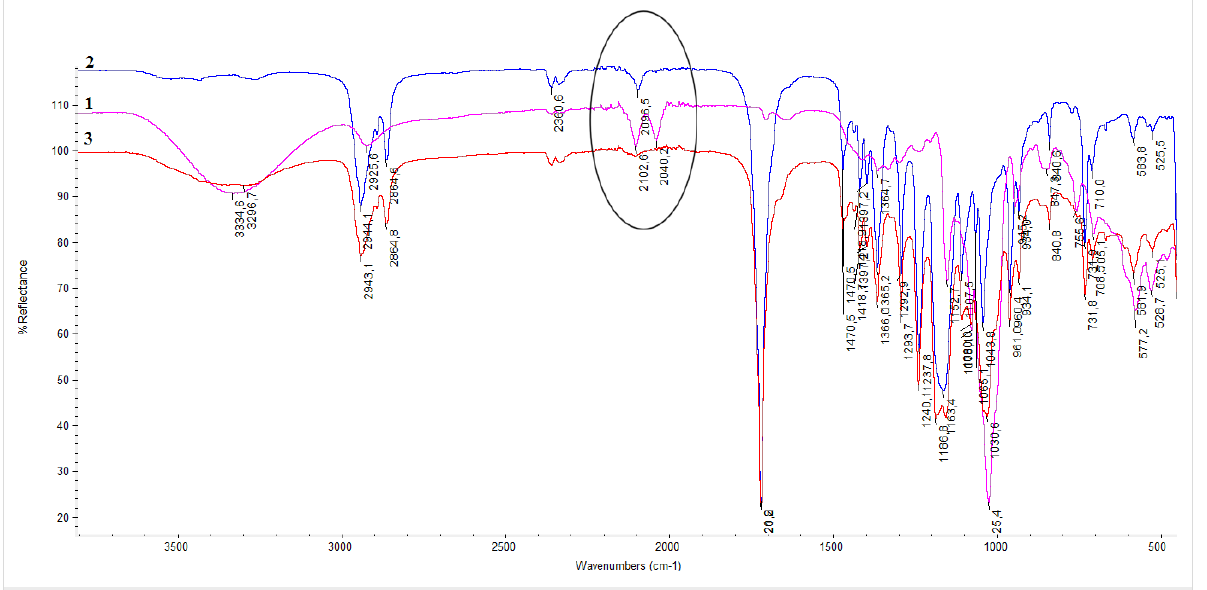
Figure 1: The FTIR spectra for (1) the mono-6-azido-CD, (2) the alkyne compound of poly( ε -caprolactone), and (3) the click reaction product.